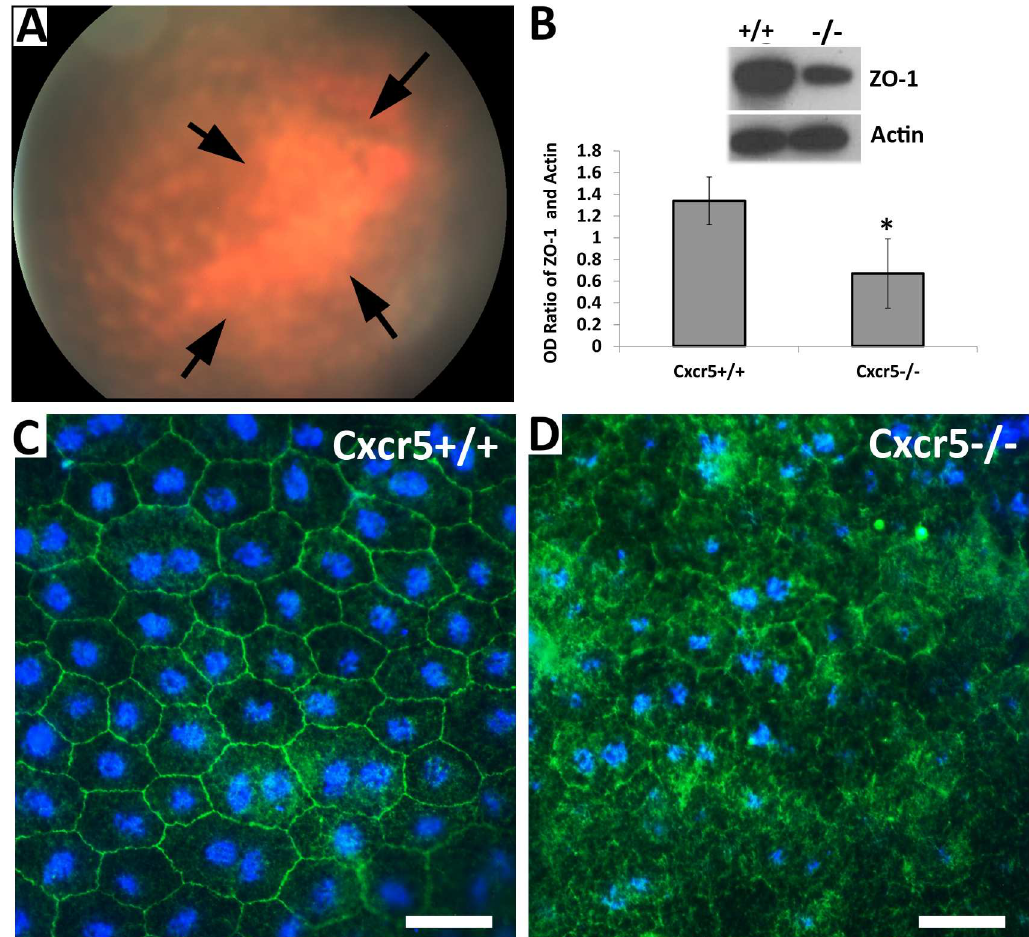
Fig 6. RPE atrophyin aged Cxcr5 -/- mice.(A) Retinalfundusimagedisplayedthe changessuggestiveof geography atrophyin the 17-month-oldCxcr5 -/- mice.Arrowsindicatedthe largedemarcatedatrophic RPEarea.( B )Westernblots (top)showedthat ZO-1 proteinwasreducedin agedCxcr5 -/- mice,comparedwiththeage-matchedWT mice.Densitometry analysis(bottom) indicatedZO-1 proteinwassignificantly reducedinthe KO ascomparedto the WT. The valueswerethe meanopticaldensity(OD) ratioof ZO-1 andActin( ± SD; n = 3). * denotedp < 0.05.( Cand D )Immunofluorescence(IF) stainingresultsrevealedthe ZO-1 (+) hexagonalgridwaswellorganizedin the RPE/choroidwhole-mounts of the WT mice ( C ),but disorganized in the Cxcr5 -/- mice( D ).Three17-month-oldC57BL/6WT miceandCxcr5 -/- micewereusedfor IF